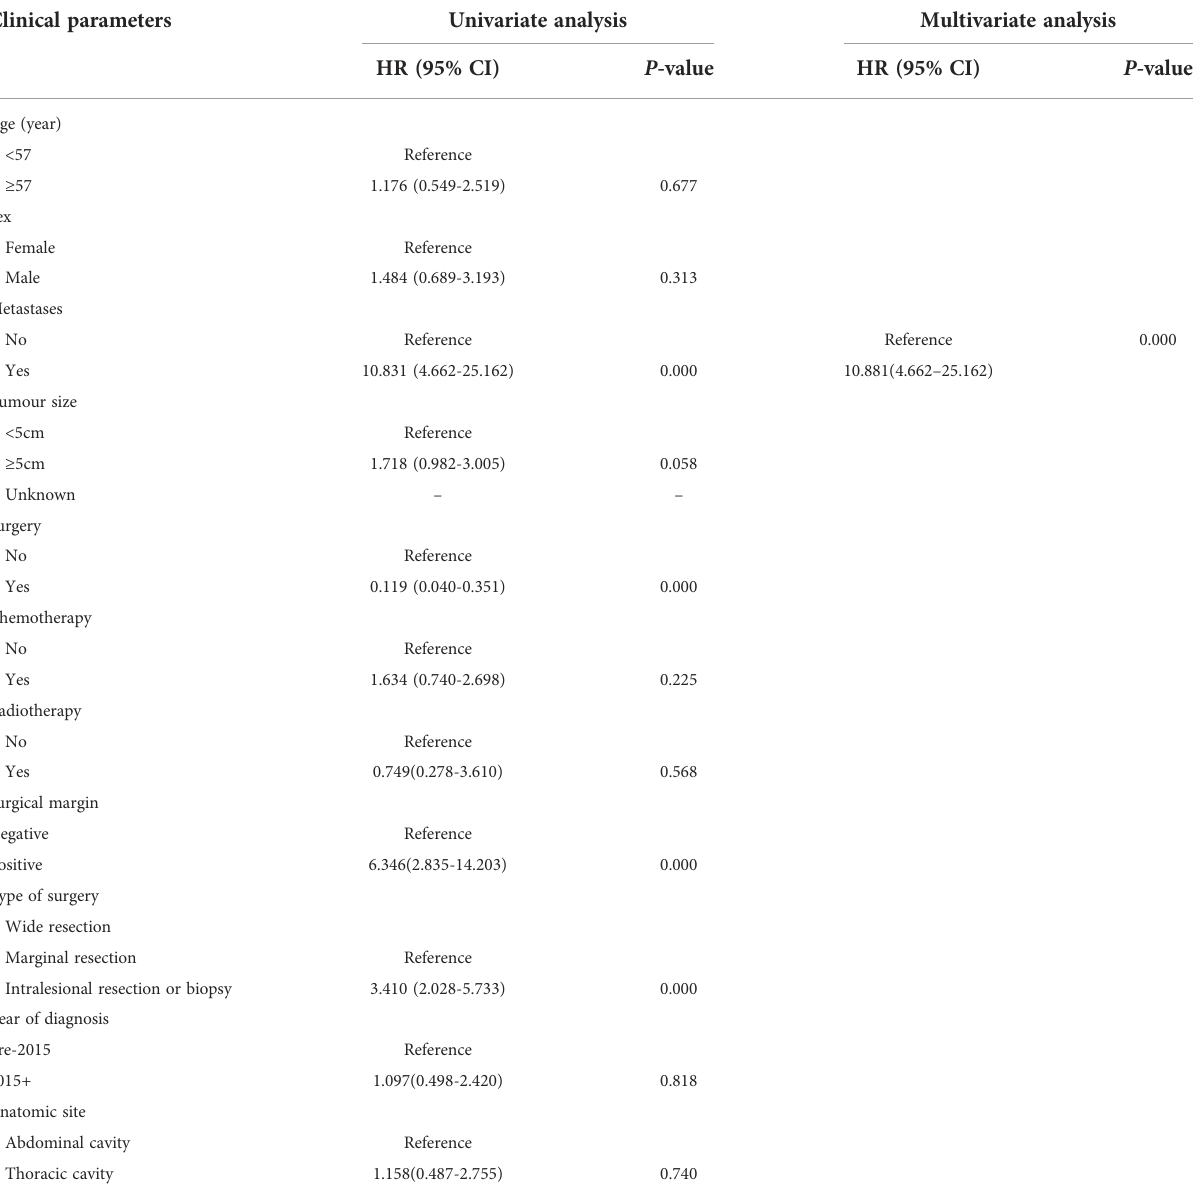
TABLE 3 Multivariable and univariate analyses of the OS in patients with visceral